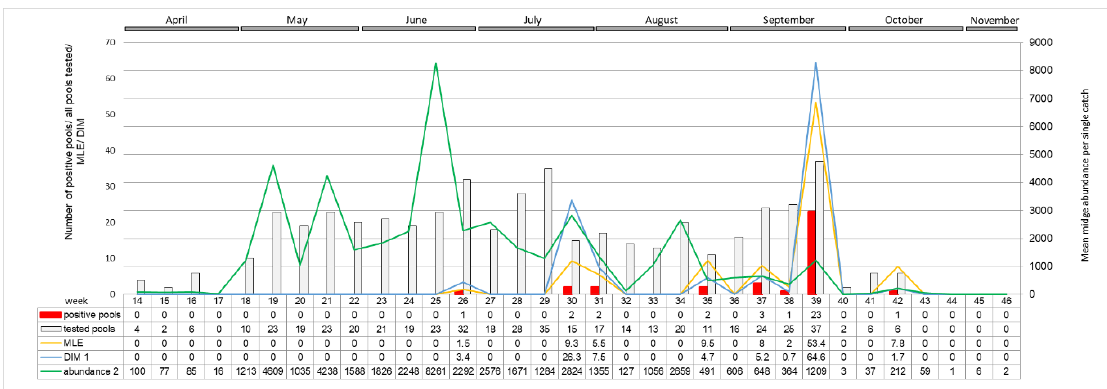
Figure 6. Weekly distribution of SBV RNA positive pools in 2016 (tested from April to October). The grey and red columns represent the numbers of tested and SBV positive midge pools. Green curve connecting the average number of individual midges caught in weekly intervals during 2016, corresponding to the right X-axis, represents the dynamics of midge week abundance. Similarly, the MLE and DIM dynamics are presented as yellow and blue curves, respectively. The original numeric data are placed below in the table. 1 DIM (Density of infected midges) calculated as proportion of mean abundance multiplied by MLE per 1000 individuals; 2 Abundance (Mean midge abundance per single catch) sum of midges trapped in consecutive week of 2016 divided by number of catches in respective week.